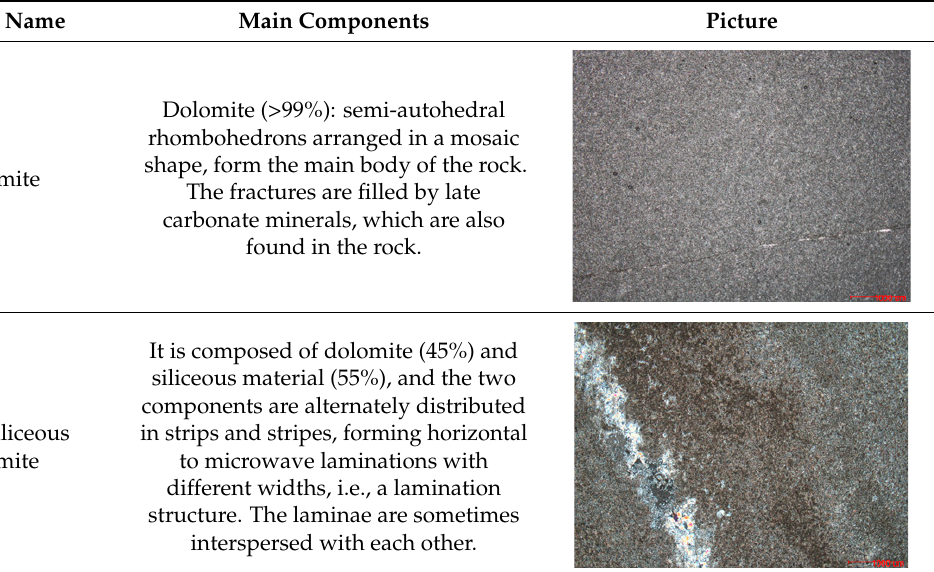
Table 1. Identification of rock ore in the Xiong’an New Area.